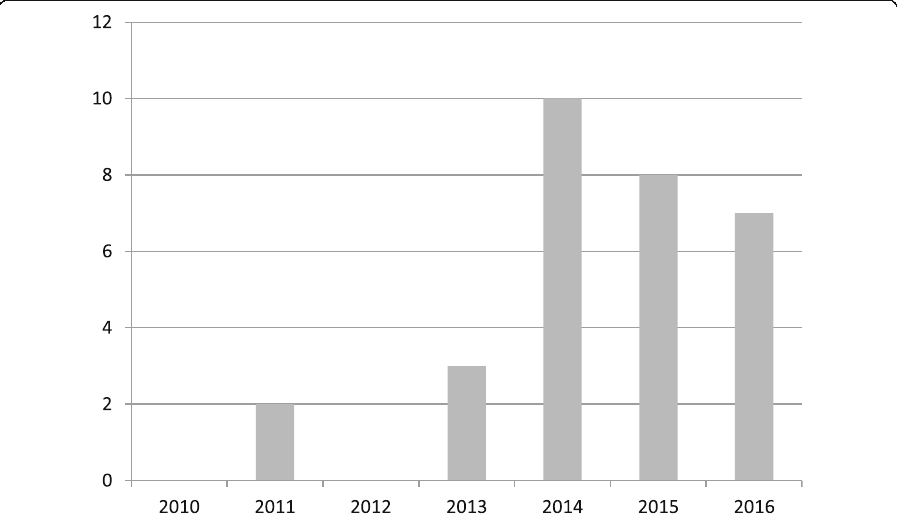
Fig. 1 Number of studies published for which data available for complete calendar year ( n =